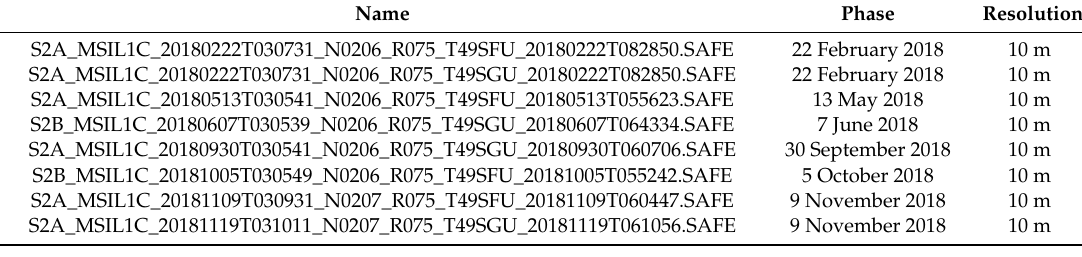
Table 1. Sentinel-2 data.